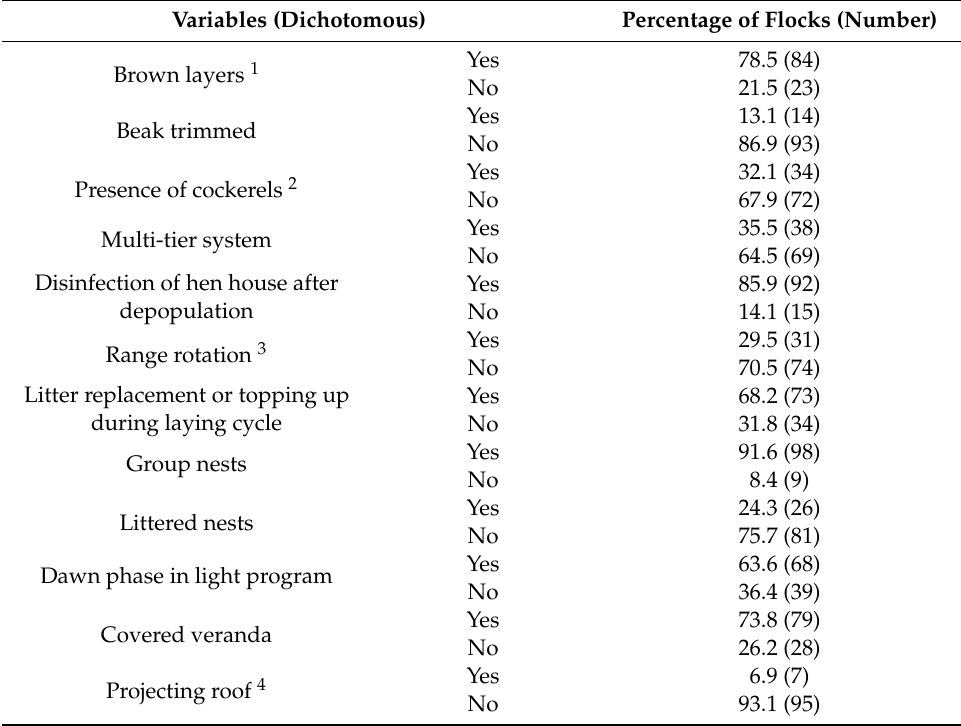
Table 3. Distribution of dichotomous husbandry characteristics in a sample of 107 organic laying hen flocks in eight European